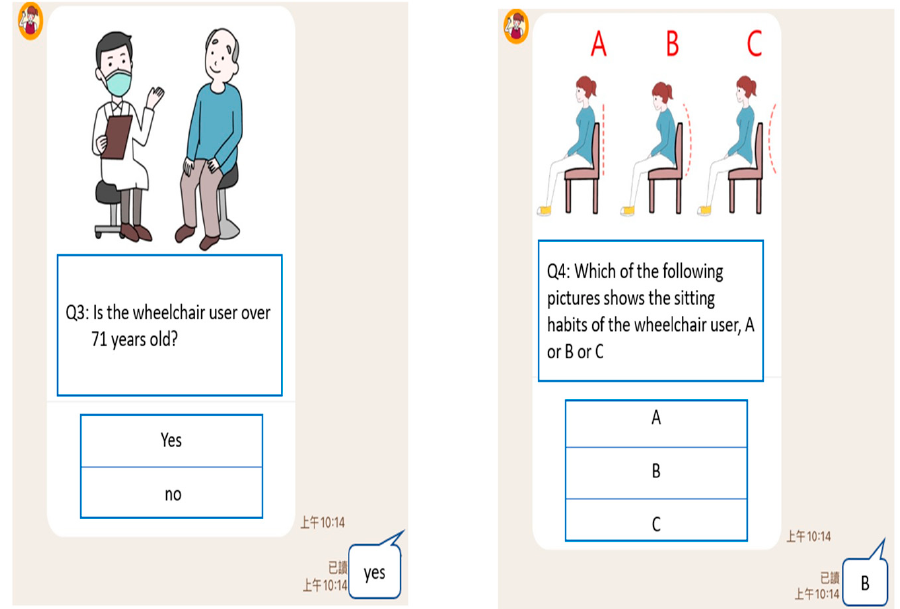
Figure 5. Assistive devices helper (LINE BOT)—Question 3 ( left )/Question 4 ( right ).